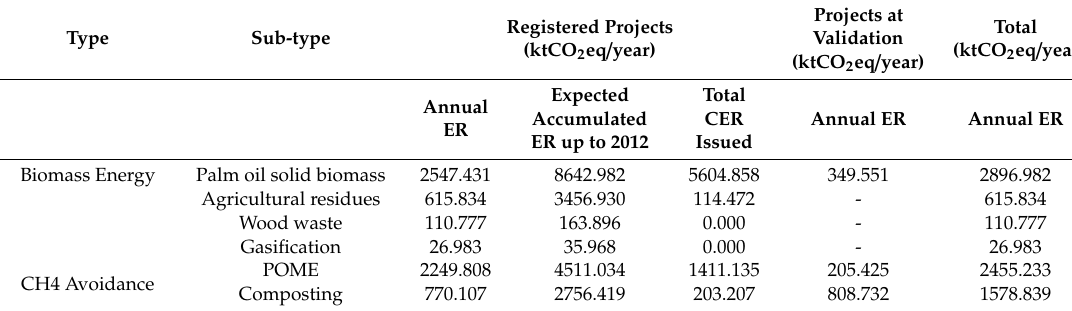
Table 3. Potential and certified emission reductions in Malaysia’s CDM pipeline in the palm oil industry